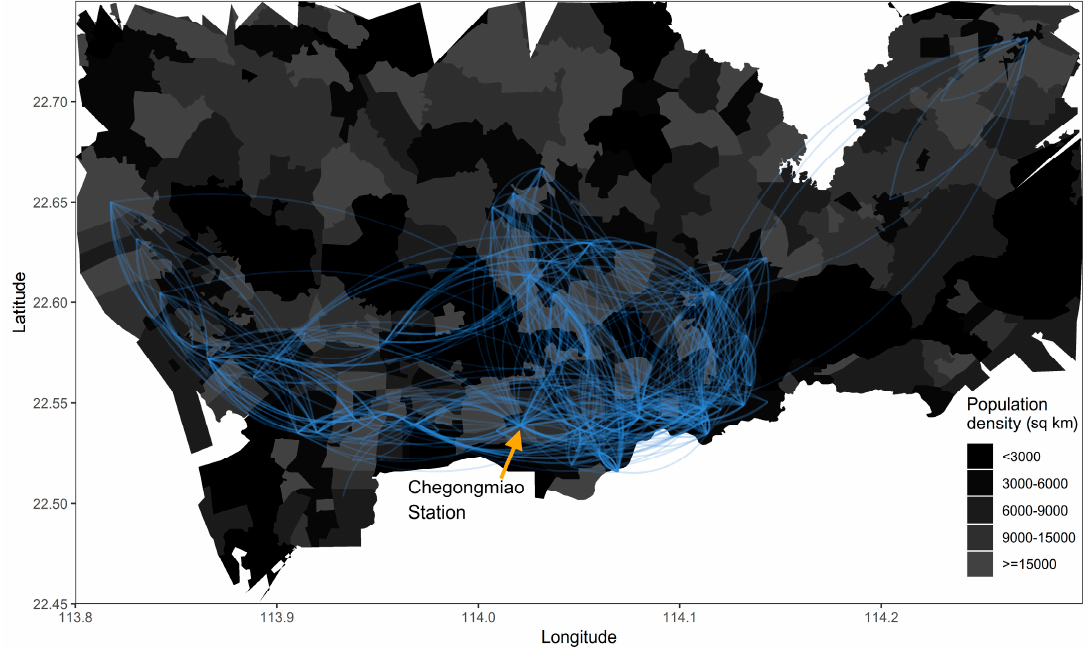
Figure 5. The flow map of metro trips (origin destination), where the daily average trip between two stations is more than 500 trips. The density of the shading indicates the flow volumes.